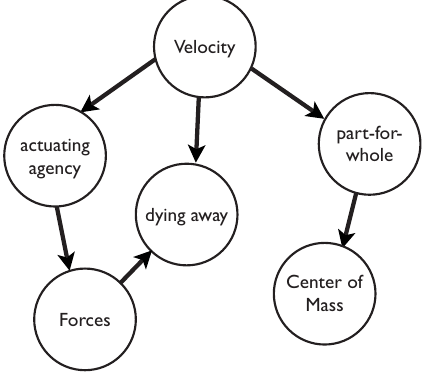
FIG. 1. Resource graph for the motion of a tossed coin. Only activated resources